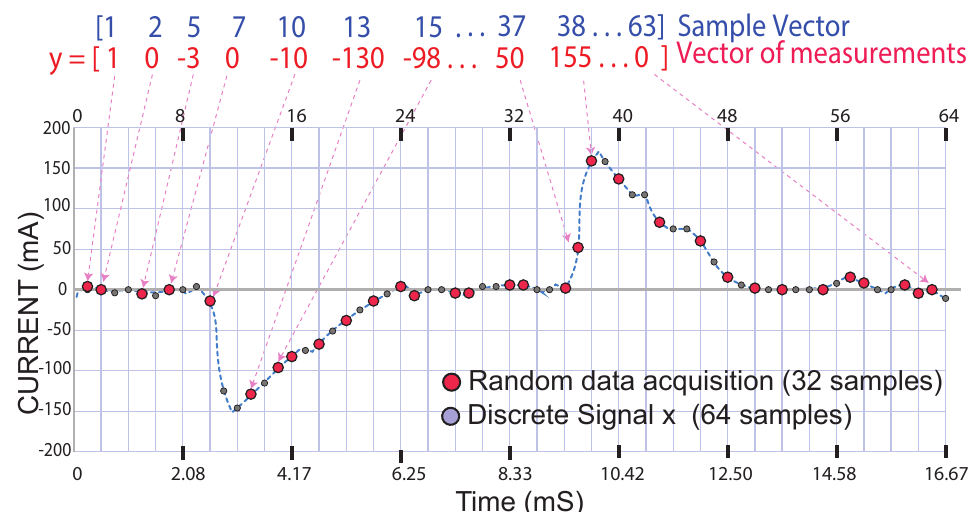
Figure 4. Obtaining the measurement vector of the discrete signal (x) in the time domain